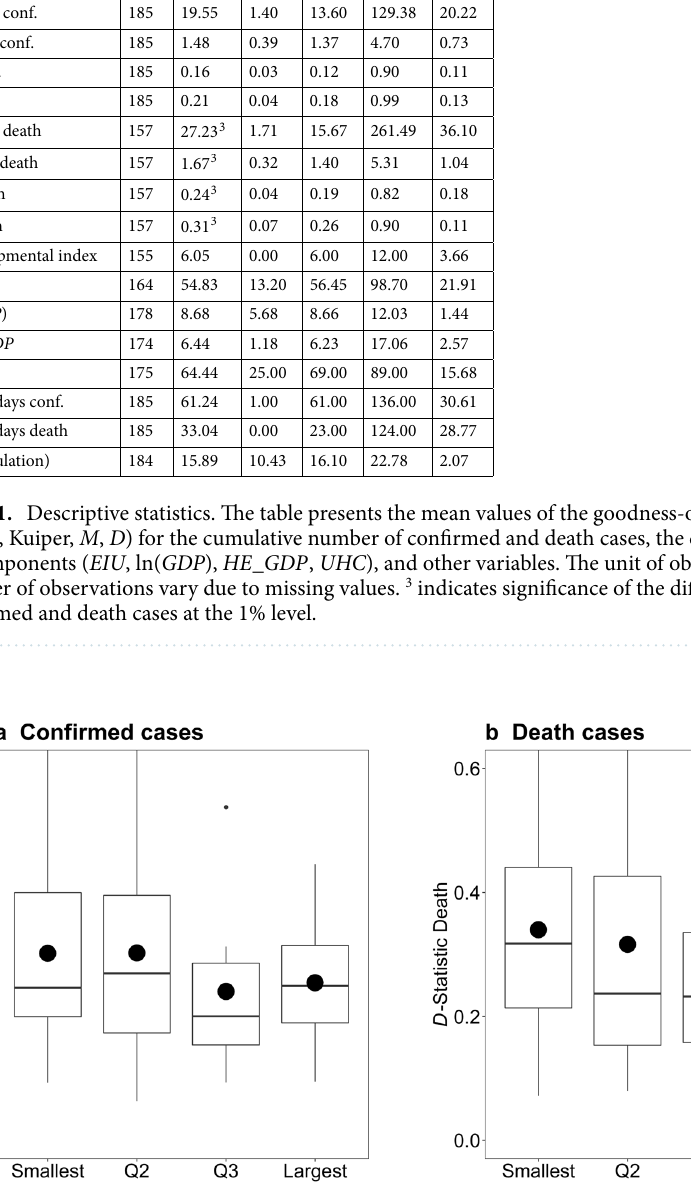
We also find that the four major economic indicators used to construct the index are highly correlated, with correlation coefficients ranging between 0.37 and 0.85 (Table 2). In unreported tests we put all economic indi- cators together in one equation on the right-hand-side and test for collinearity. The result shows the Condition Number is over 46, indicative of serious collinearity. The four goodness-of-fit measures are also highly correlated with each other, as are the total number of confirmed cases and the country’s population.